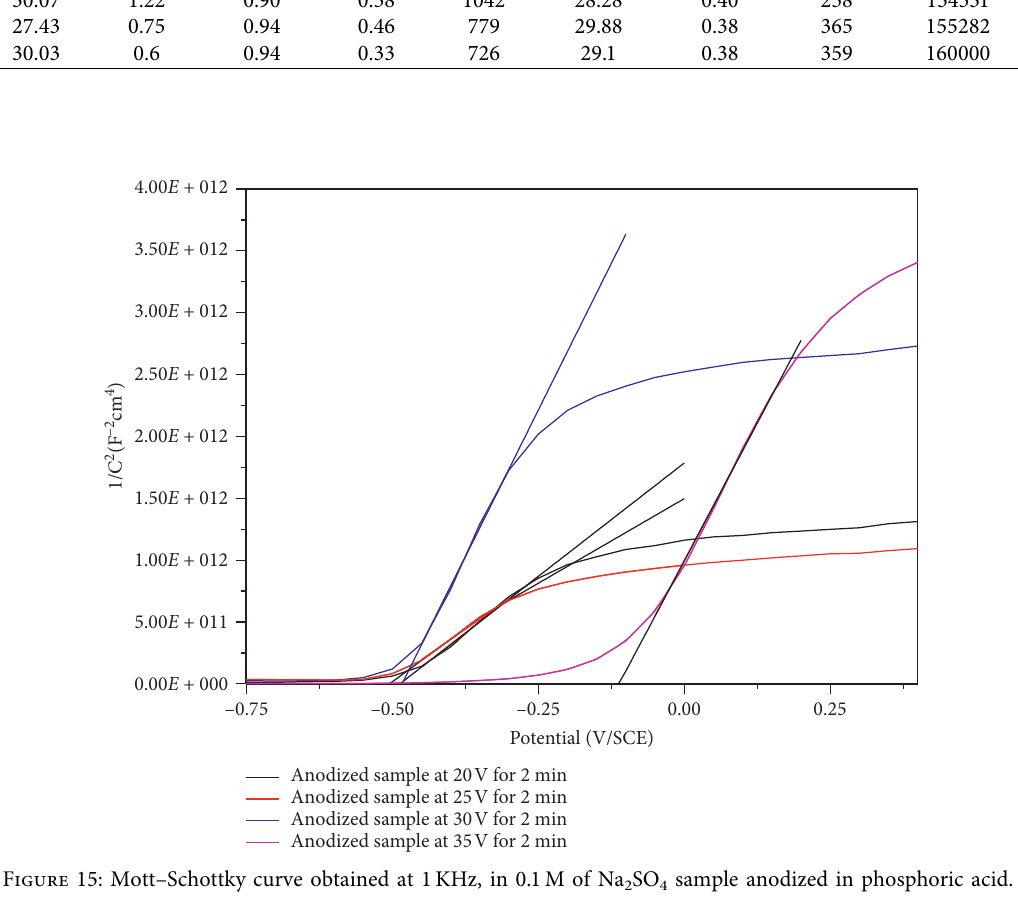
2 SO 4 sample anodized in phosphoric